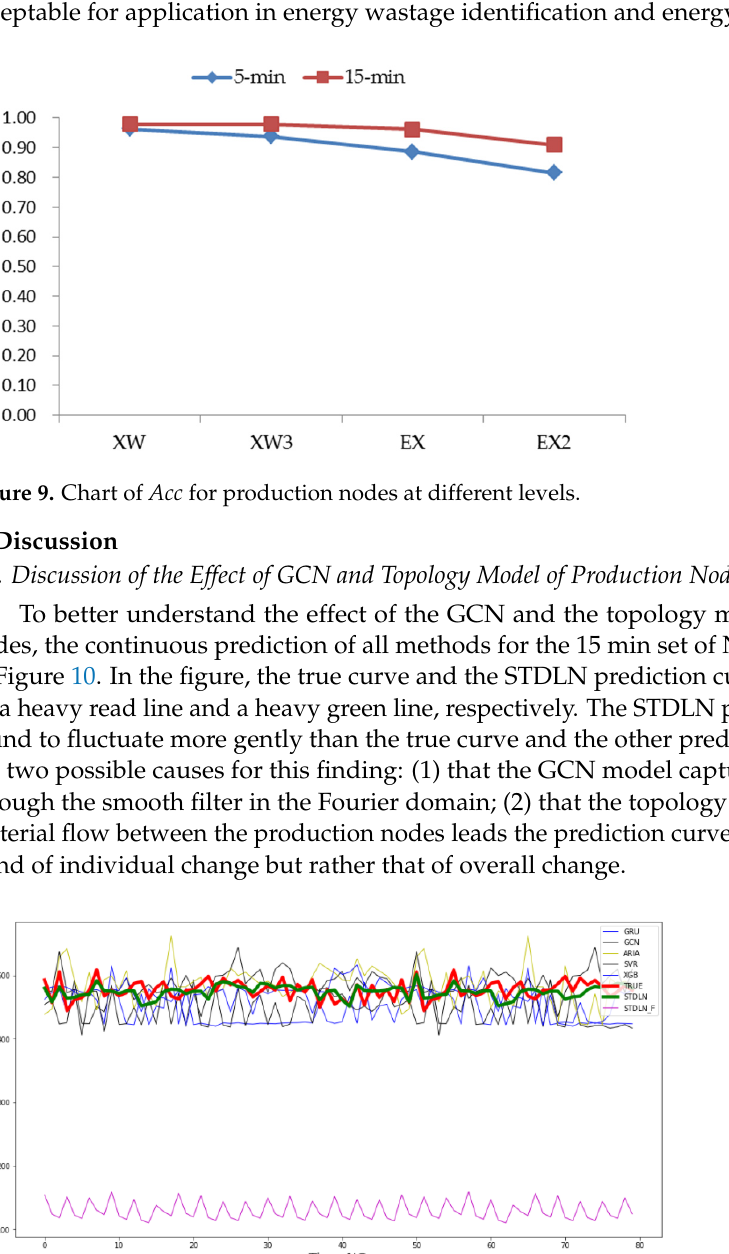
Figure 8. The scatter diagram of the Acc for all methods and all datasets.